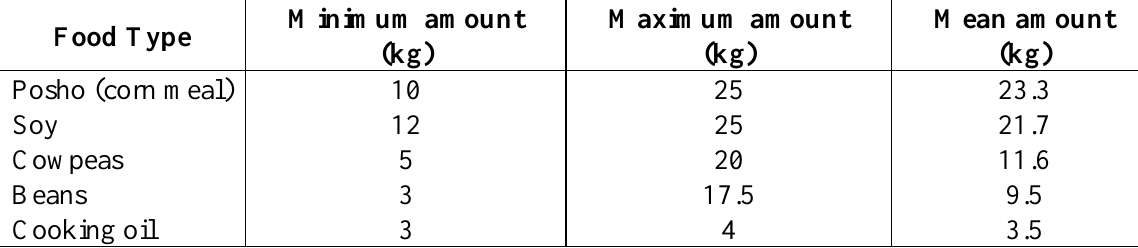
Table 3. Average monthly food quantities (kg) received by 23 members of TASO, a community-based AIDS support